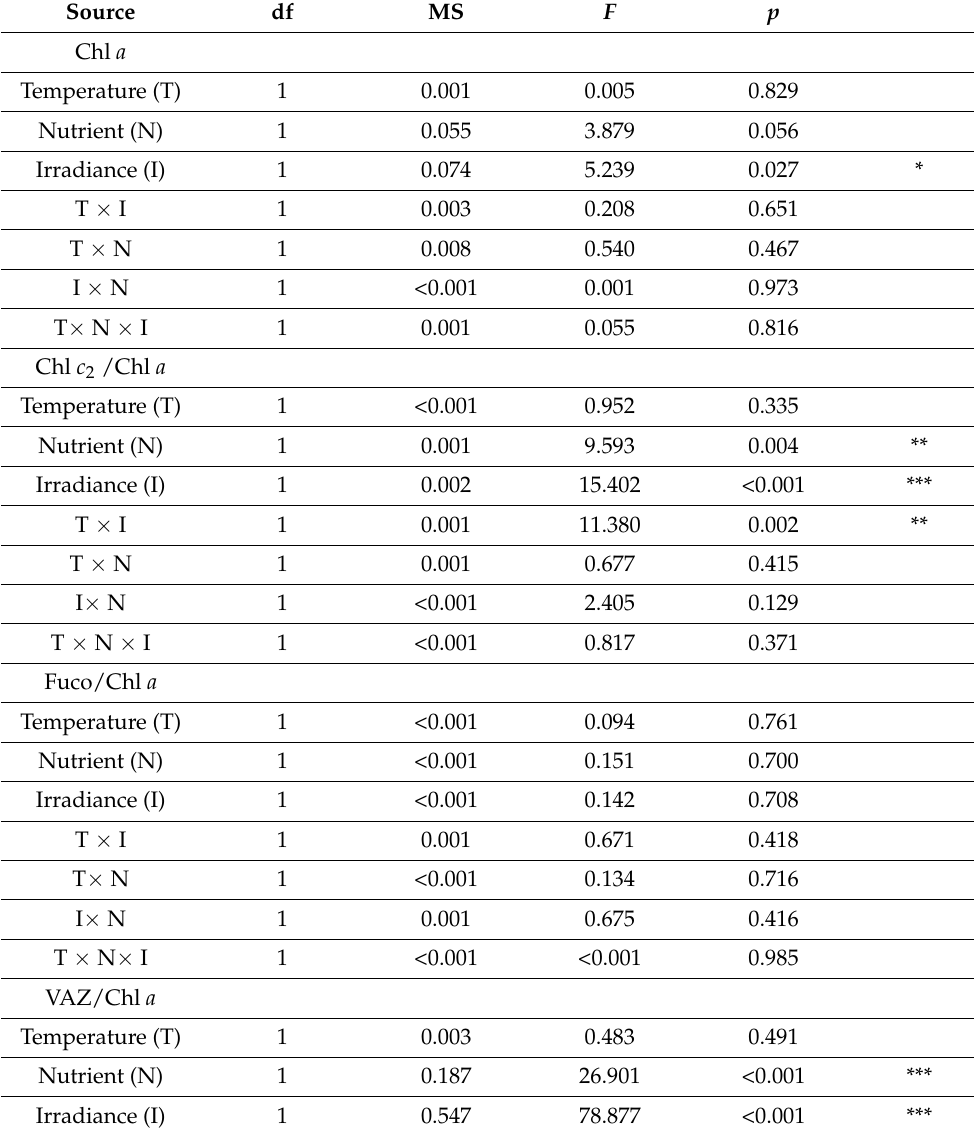
Table 2. Results of three-way ANOVA on the effects of temperature, nutrients, and irradiance on photosynthetic pigment content of Sargassum fusiforme . Sources that are significant at p < 0.05, p < 0.005 and p < 0.001 are denoted as ‘*’, ‘**’ and ‘***’